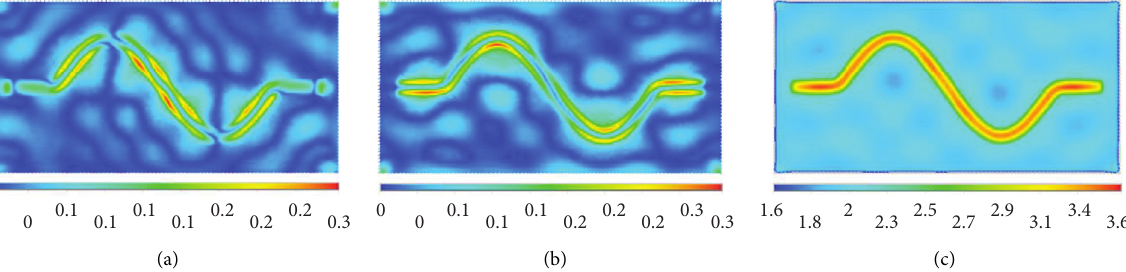
Figure 28: P wave incident ( H � 125m, f � 2.0Hz, C